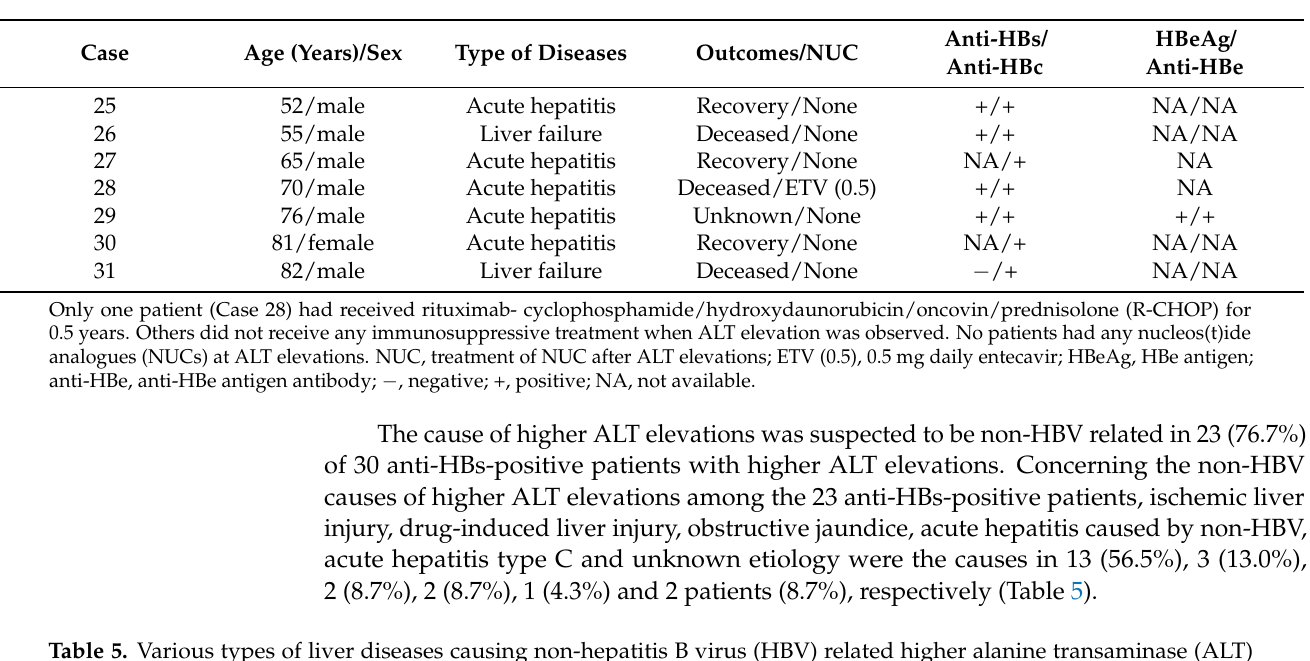
Table 4. Highly suspected hepatitis B virus (HBV) patients with HBV surface antigen (HBsAg)-negativity but anti-HBV surface antibody (anti-HBs)/anti-HBV core antibody (anti-HBc)-positivity and alanine transaminase (ALT) elevations higher than 1000 IU/L.